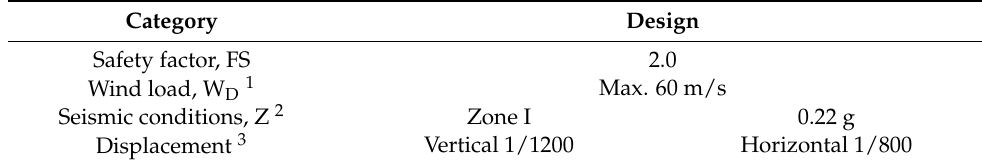
Figure 5. Location of the tower (red dot) and central control room (black dot). (Source: Google maps).